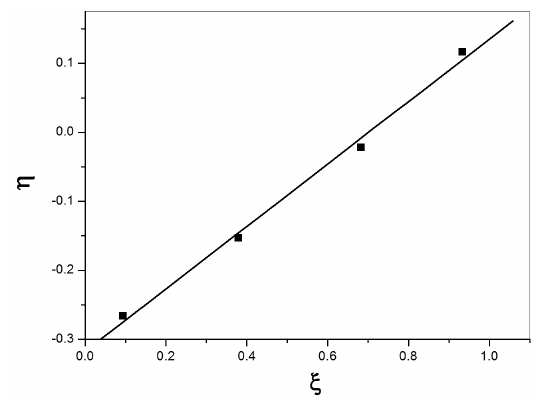
Figure 5. Kelen-Tudos plot of η vs. ξ.